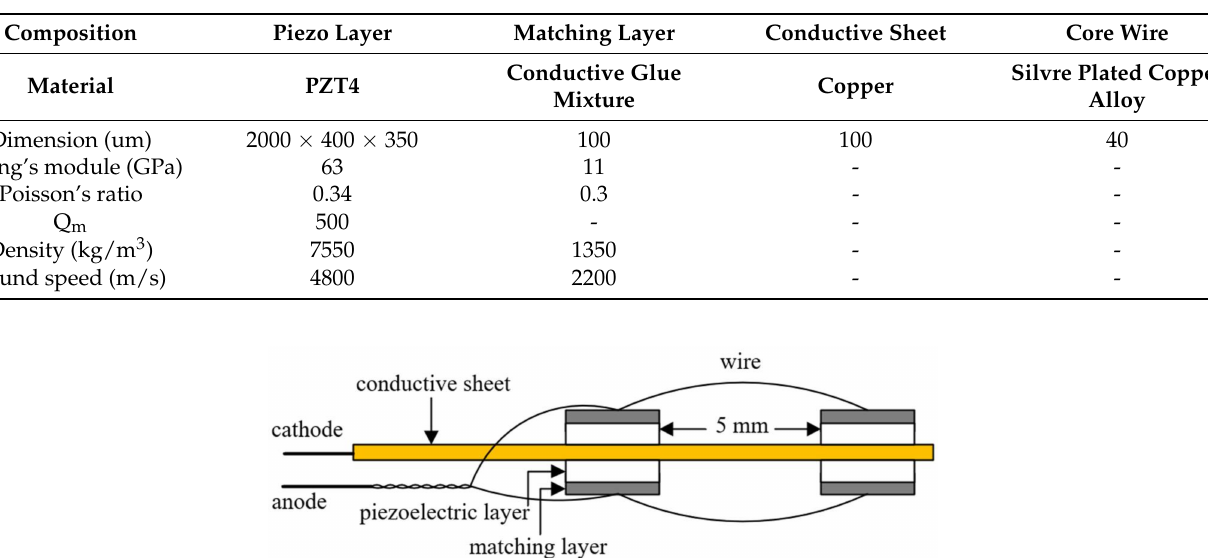
Table 1. The physic properties of the ultrasound-based prototype catheter.